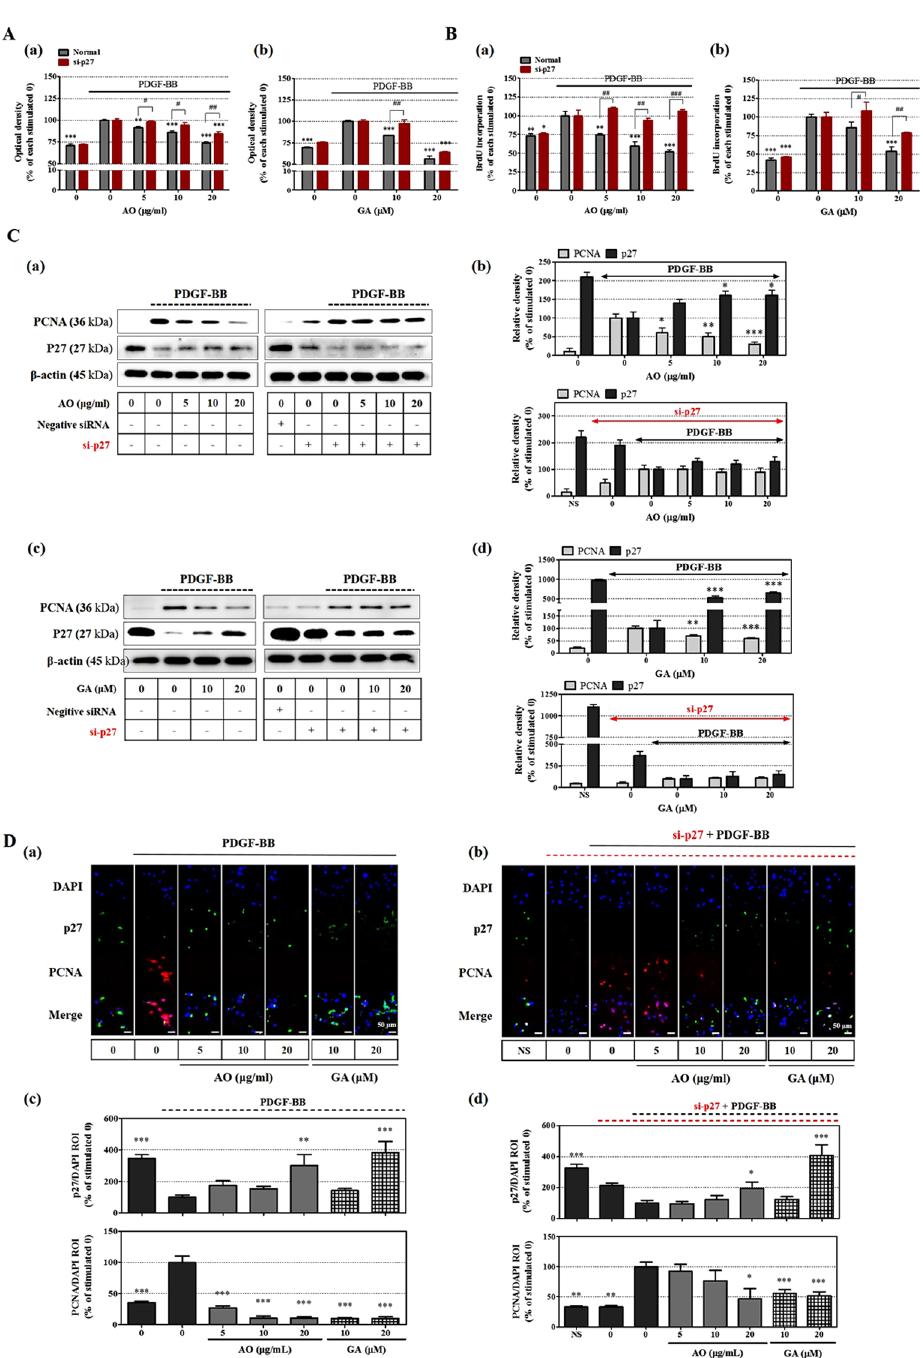
Figure 4. Identification of p27 up-regulation as the target of action in the anti-proliferative activity of the AO extract and GA. VSMCs were transfected with the siRNA of p27 (si-p27) for 6 h using TransIT-X2 and were then stimulated by 25 ng/mL PDGF-BB for 24 h. ( A ) The anti-proliferative effects and ( B ) the effects on BrdU incorporation of the AO extract (a,c) and GA (b,d) were determined on VSMCs in which p27 expression had been silenced at 450 nm using the WST-1 assay (n = 4) and on DNA synthesis (n = 4). ( C ) The inhibitory effects of the AO extract (a,b) and GA (c,d) on PCNA and p27 KIP1 expression in the presence or absence of si-p27 were examined using SDS-PAGE followed by immunoblotting; β -actin was used for normalization and the results were analyzed using densitometry. ( D ) PCNA and p27 KIP1 expression were also examined using an immunofluorescence assay in the presence (a) or absence (b) of si-p27, using the fluorescence levels of DAPI for normalization (c,d); the levels of immunofluorescence were analyzed using densitometry and the values represent percentages relative to the stimulated control (n = 5). Images are presented at their original magnification (400 × , scale bar: 50 μ m). The results are an average of four or more similar, independent experiments and are expressed as the mean ± SEM. Significant differences relative to the PDGF-stimulated controls are indicated by asterisks: * P < 0.05, ** P < 0.01, *** P < 0.001. The full size blot is shown in Supplementary Figure